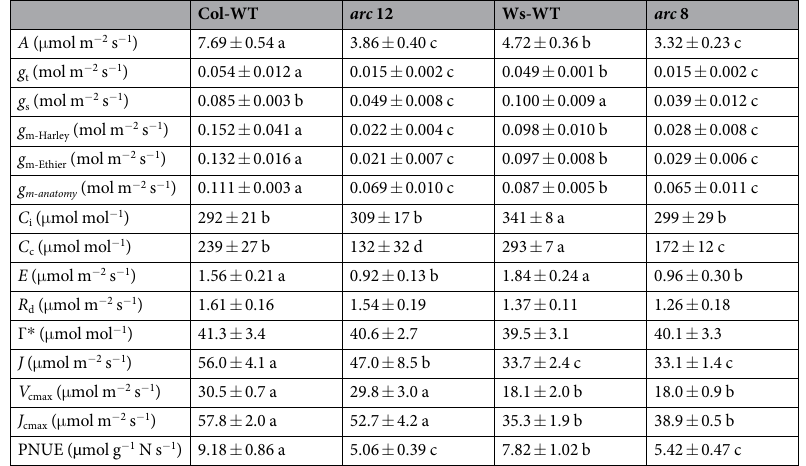
Table 2. Leaf functional characteristics. The values shown are the mean ± SD of three replicates. The means were compared with a least significant difference (LSD) test; values followed by the same letter are not significantly different ( P < 0.05). A , g s , g m , g t , C i and C c were measured at a CO 2 concentration of 400 μ mol